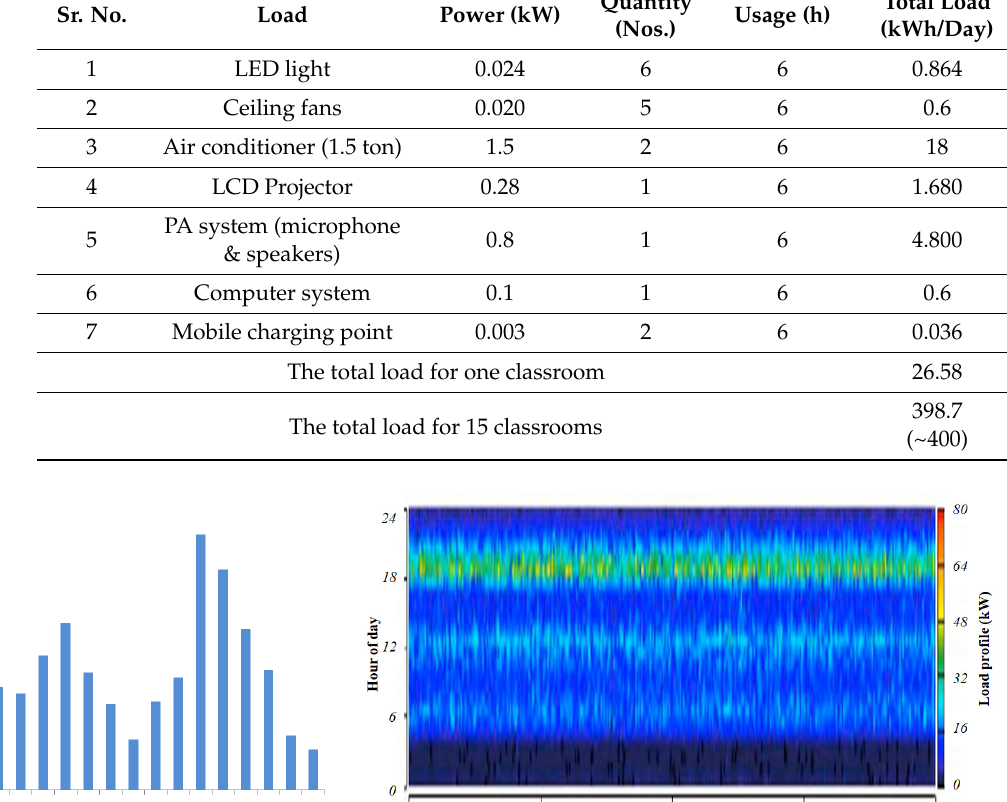
Figure 11. Block diagram process of HOMER software.